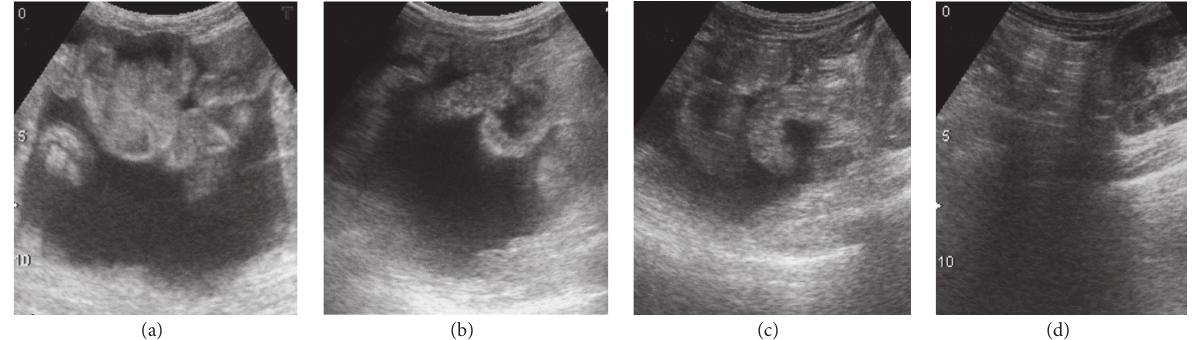
Figure 2: Lower abdominal ultrasonography.(a)Before percutaneousabdominal puncture;(b) 2weeks afterabdominal puncture;(c)4 weeks after abdominal puncture; and (d) 6 weeks after abdominal puncture (ascites completely